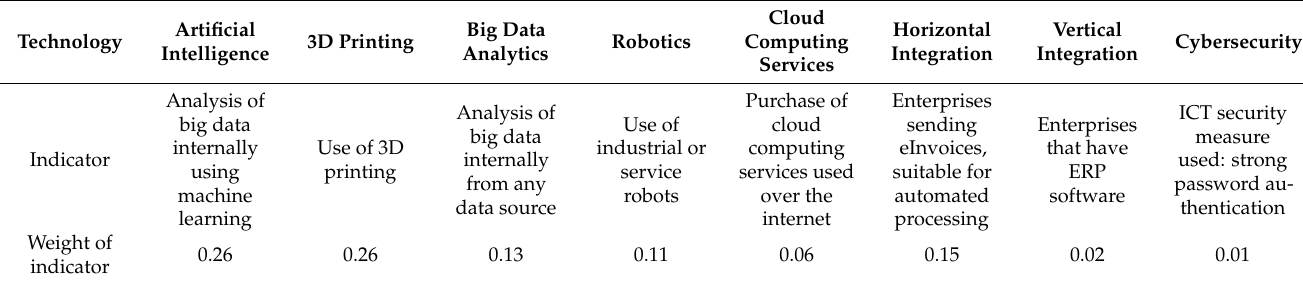
Table 6. Weights for indicators used in the study regarding digital maturity of the EU countries.